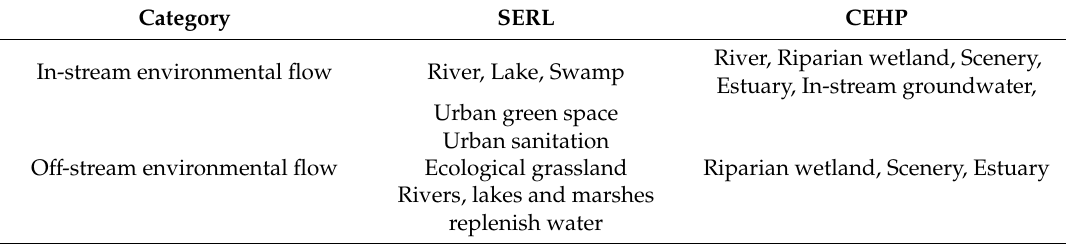
Table 3. The comparison of application of the two standards for development of water use projects.